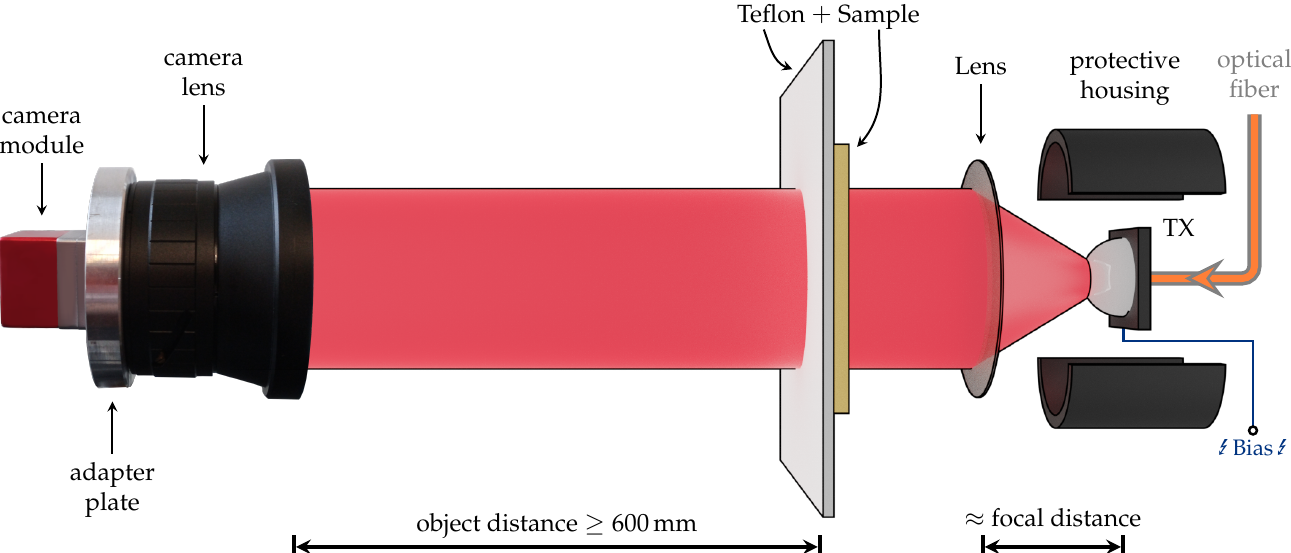
Figure 2. Schematic of the lens-based imaging setup. The THz emission of the TX is collimated by a silicon lens ( f = 25mm) before it reaches the sample. To suppress the thermal image, the sample is mounted onto a sheet of Teflon. The transmitted radiation is recorded with the camera/lens combination ( f = 44mm) placed more than 600mm away from the object plane. Drawing not to